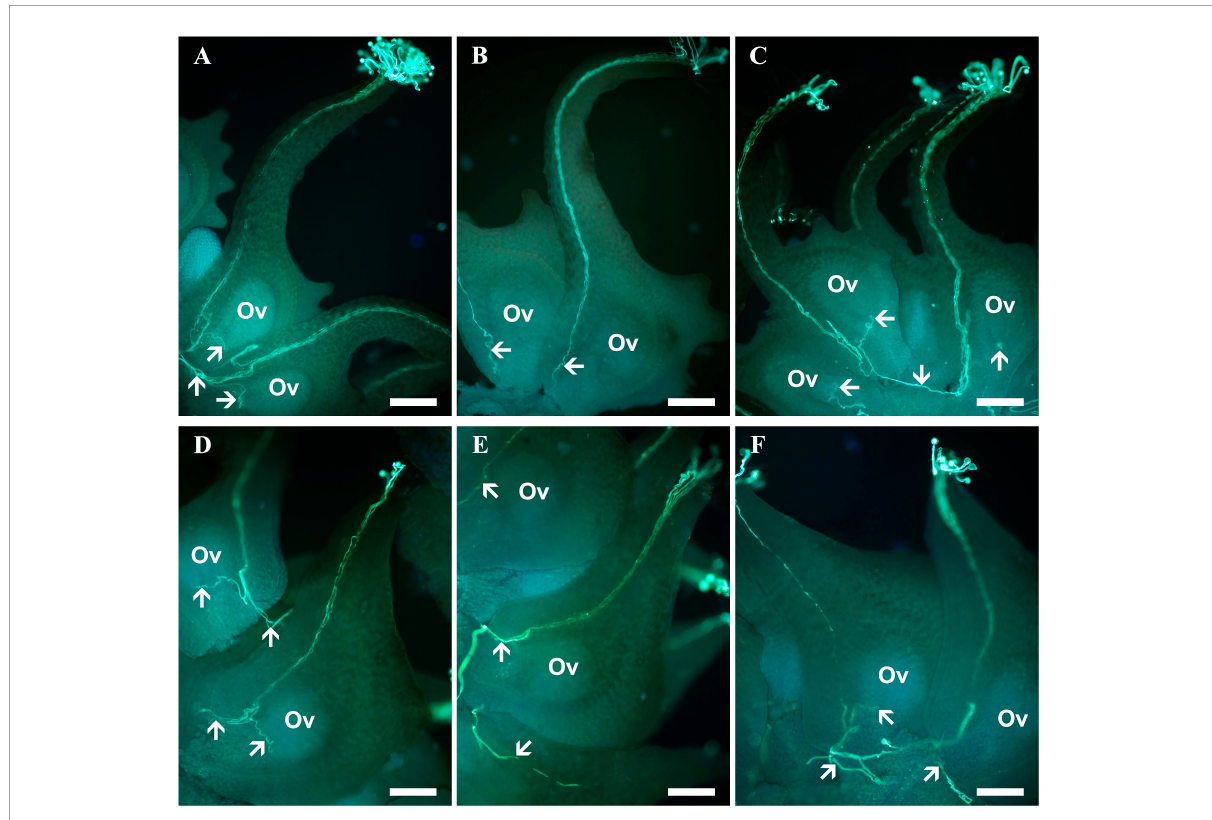
FIGURE2 Pollen tube growth in the pistils of Sagittaria pygmaea and S. trifolia after conspecific and heterospecific pollination observed under a fluorescence microscope. (A) Pollen tubes of S. pygmaea arriving at the base of the carpel, with one of them entering into the micropyle at 1.5 h after conspecific pollination. (B) Pollen tubes of S. trifolia arriving at the base of the S. pygmaea carpels at 1.5 h after heterospecific pollination. (C) Pollen tubes of S. trifolia passed through the basal carpel opening enter into other unfertilized ovules at 3 h after heterospecific pollination. (D) Pollen tubes of S. trifolia arriving at the base of the carpel, with one of them entering into the micropyle at 1.5 h after conspecific pollination. (E) Pollen tubes of S. pygmaea arriving at the S. trifolia base of the carpel at 1.5 h after heterospecific pollination (F) pollen tubes of S. pygmaea passed through the basal carpel opening enter into other unfertilized ovules at 3 h after heterospecific pollination. White arrowheads denote pollen tubes. Ov, ovule; Scale bar: 200 µ